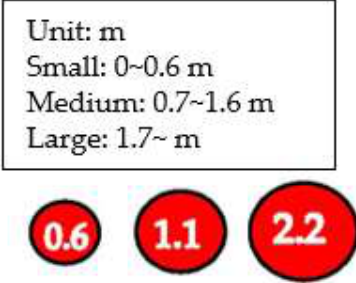
Figure 5. The levels of wave height.